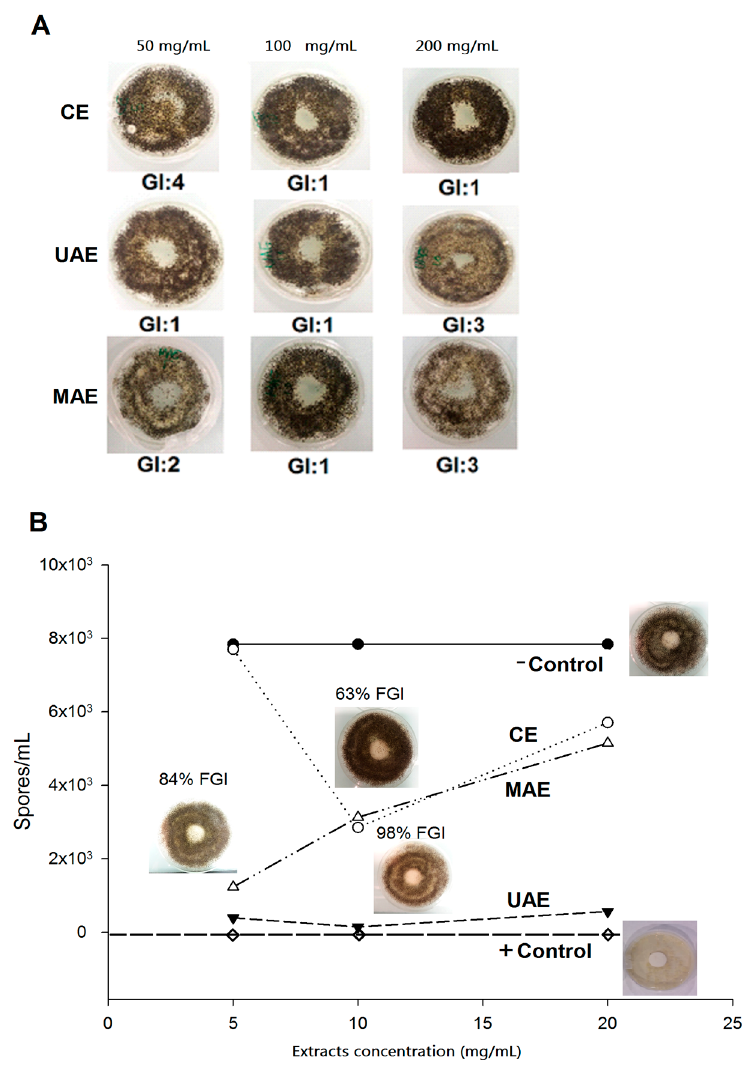
Figure 5. Antifungal activity of Nectandra grandiflora extracts against Aspergillus niger by the potato dextrose agar method ( A ) and cellulose pellets method ( B ). GI: Growth intensity; FGI: Fungal growth inhibition; CE: Conventional Soxhlet extraction; UAE: Ultrasound-assisted extraction; MAE: Microwave-assisted extraction.